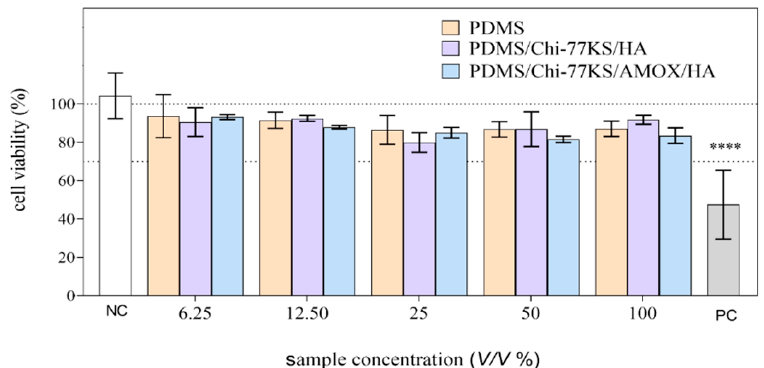
Figure 12. Viability of L929 cells after 24 ± 1 h of exposure to the PDMS disc extracts (6.25, 12.5 25, 50 and 100 V / V % corresponding to 0.0781, 0.1563, 0.3125, 0.625 and 1.25 cm 2 /mL, respectively). Data are presented relative to the vehicle control (VC)–growth medium, incubated under extraction conditions. Fresh growth media was used as the negative control (NC) and etoposide (100 µ g/mL) as the positive control (PC). The asterisks denote a statistically significant difference between the sample and VC (**** p < 0.001, ANOVA).